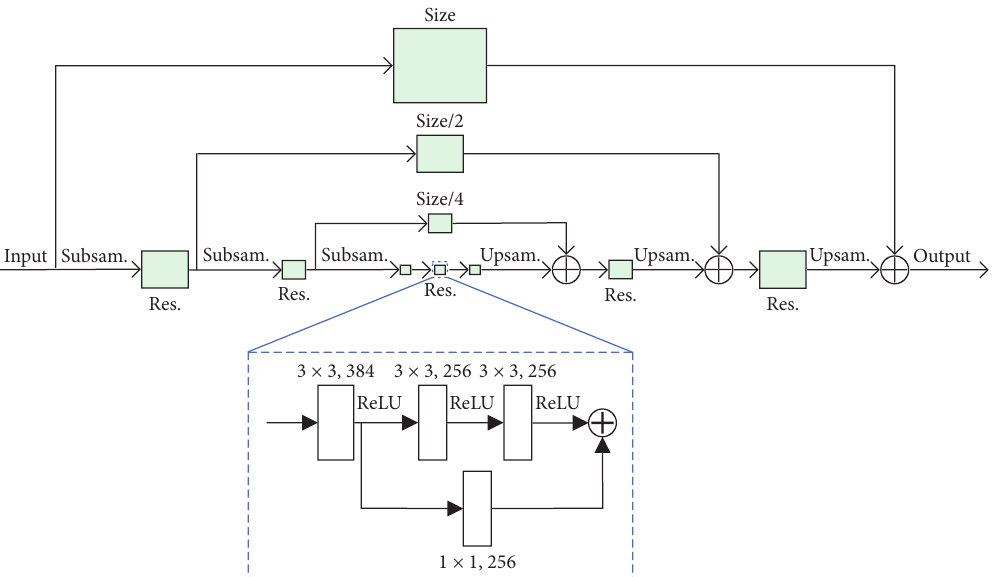
Figure 3: An illustration of a single “hourglass” module. Each hourglass is a modular network with a symmetrical structure. Each box represents a single residual